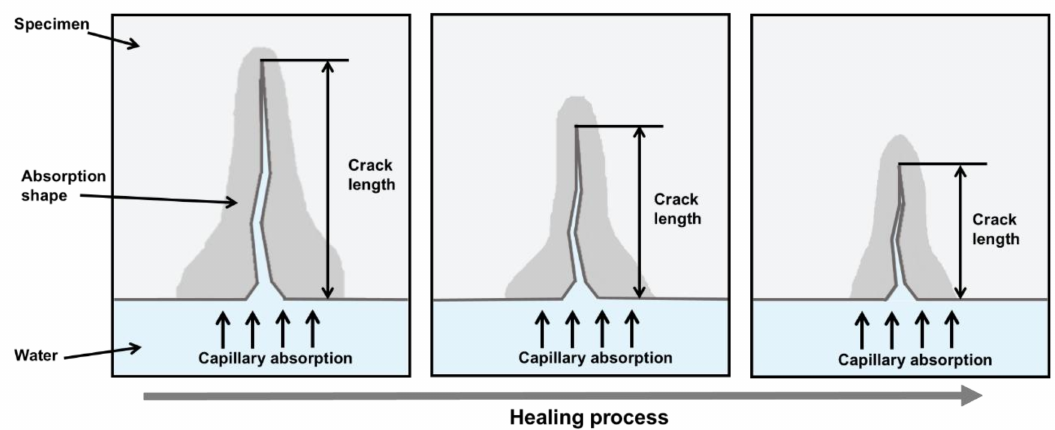
Figure 3. Schematic of change in capillary water absorption through crack as healing